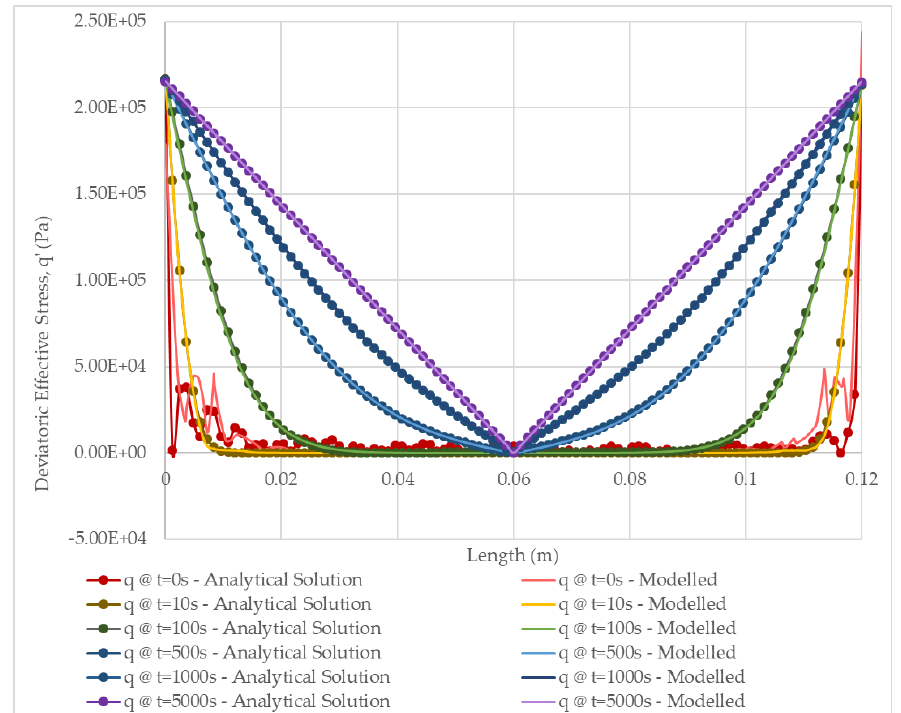
Figure 10. Verification study — 1D transient solution results for deviatoric effective stress over the length of the specimen.